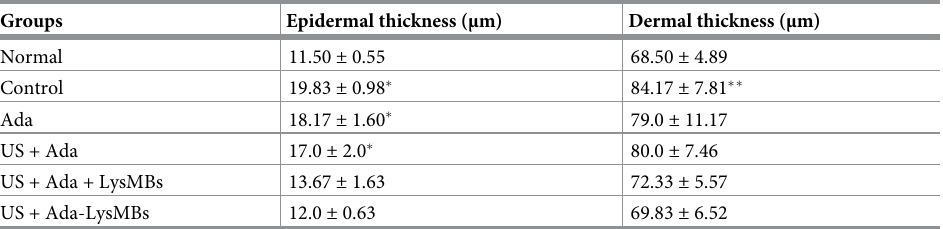
Table 3. Epidermal and dermal thickness in BALB/c mice at the end of the in vivo wrinkle experiment.